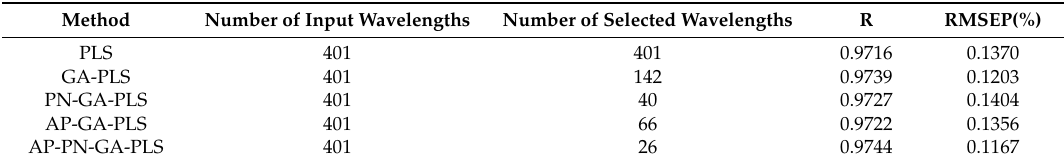
Table 5. The average values of the number of selected wavelengths, R, and RMSEP using PLS, GA-PLS, PN-GA-PLS, AP-GA-PLS, and AP-PN-GA-PLS (diesel